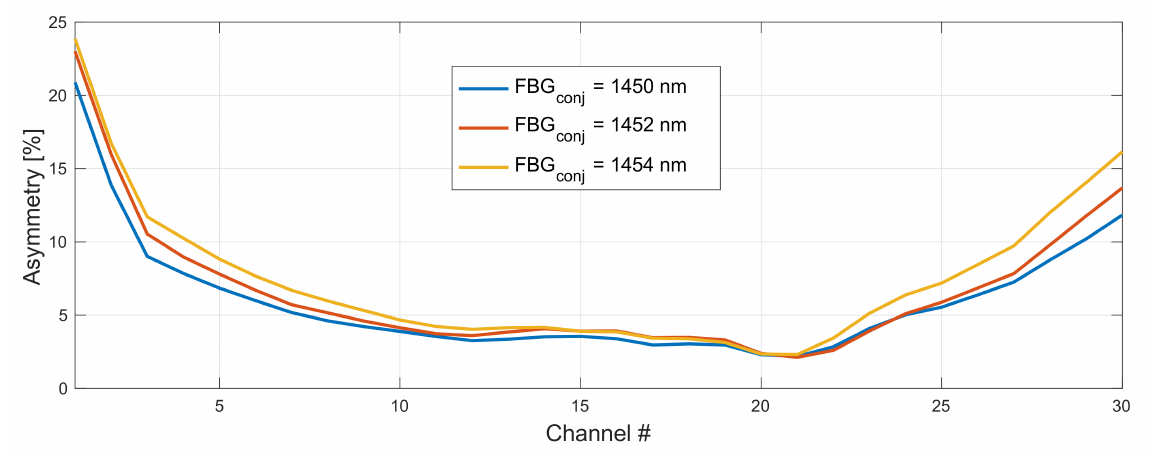
Figure 8. Impact of a FBG choice on asymmetry performance in 192–198 THz grid. FBG for original WDM grid was set to 1460 nm and conjugated varied from 1450–1454 nm.